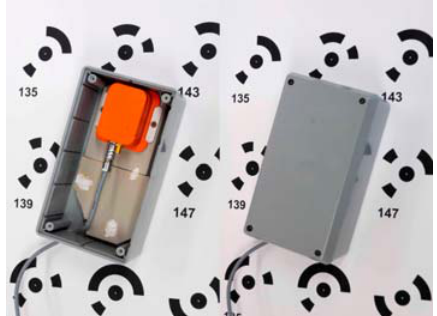
Figure 3. Ground control box prototype with north facing and heading reference sensor on a test field